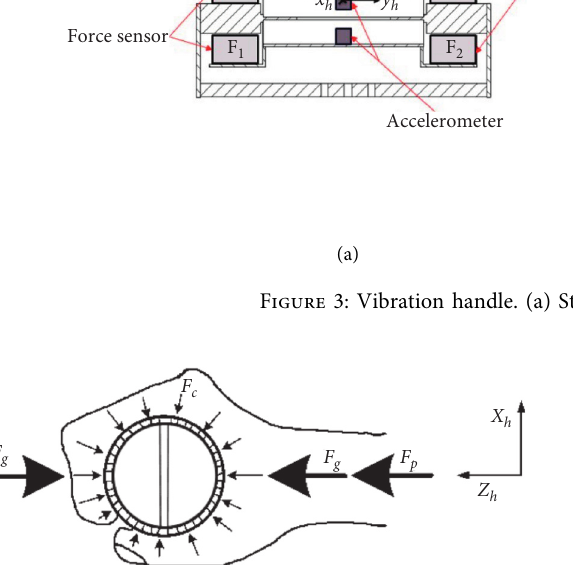
Figure 4: Sketch map of hand contact force ( F and push force ( F p ).